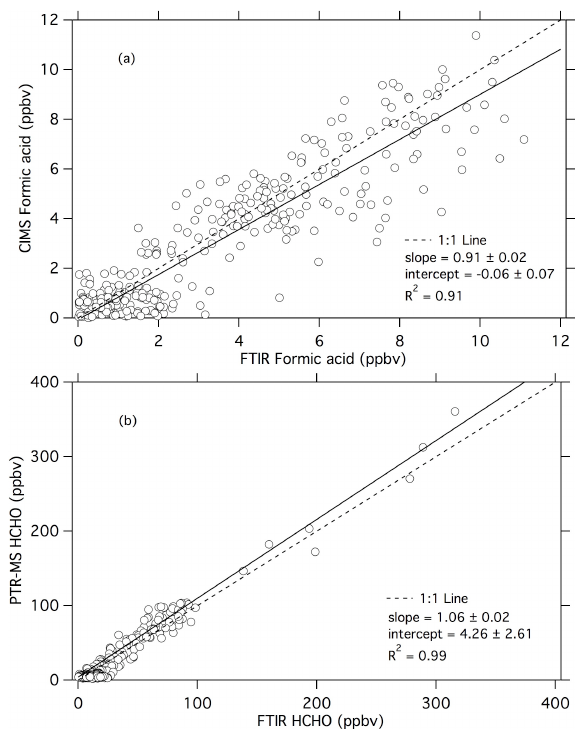
Fig. 6. A comparison of NI-PT-CIMS formic acid and PTR-MS formaldehyde measurements to simultaneous measurement of OP- FTIR formic acid and formaldehyde. NI-PT-CIMS was calibrated using a formic acid permeation source that was standardized using MOCCS. PTR-MS was calibrated for formaldehyde measurement with a permeation source that was standardized using MOCCS.